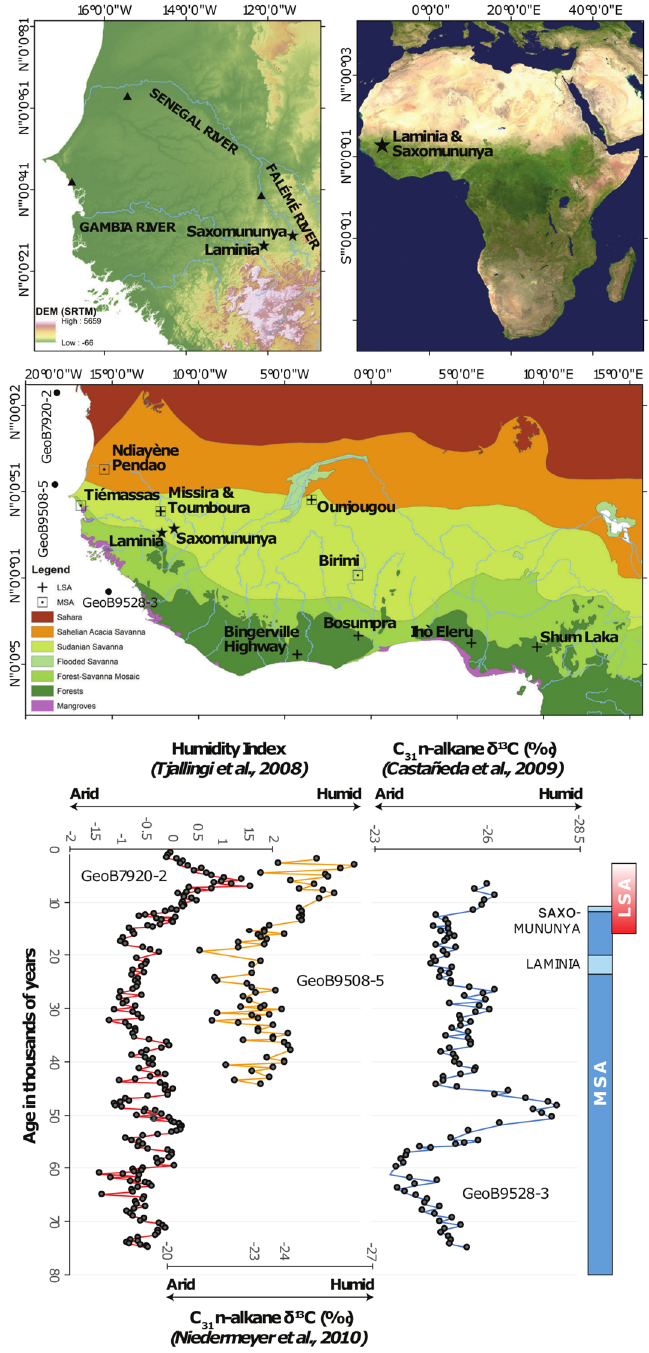
Figure 1. Site locations and chronological details. Maps illustrating the location of Laminia and Saxomununya in relation to the topography and major fluvial systems of Senegal (top left; SRTM DEM 63 ), their position within Africa (top right; Image: NASA), and in respect to other key dated West African MSA and LSA sites, emphasizing the association of the MSA sites with Sudanian savannahs and the early LSA sites with tropical forest ecologies (centre yy 64 ). (Bottom) The chronology of MSA (blue) and LSA (red) with the ages of Laminia and Saxomununya highlighted in light blue, against three Marine Core datasets indicating substantial directional change in humidity (left; 48 ) and patterns of vegetation (centre ( 49 ); right ( 50 )) at the MSA-LSA